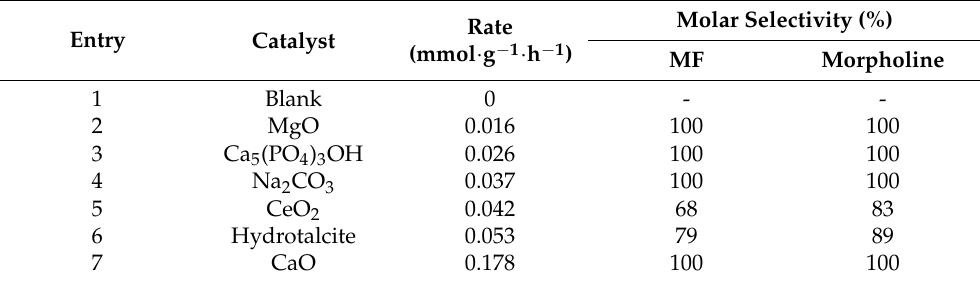
Table 1. Reaction rate and product selectivities of NFM alcoholysis reaction over different solid base catalysts. Entry Catalyst